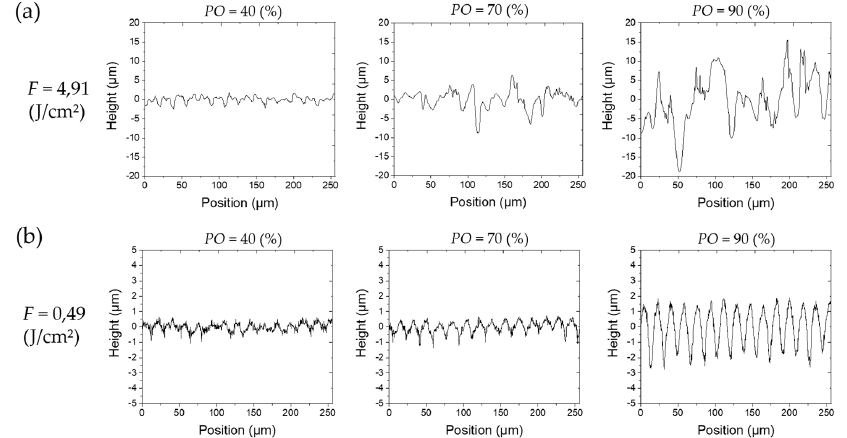
Figure 5. Exemplary height elevation profiles in x-direction for different PO (40%, 70%, and 90%) and different fluences ( F = 4.91 J/cm² and F = 0.49 J/cm²), respectively. ( a ) A clear formation of stochastic microstructures can be observed at a high level of PO at F = 4.91 J/cm². Width and height of the structures rise with increasing PO . ( b ) At F = 0.49 J/cm², the height of deterministic structures grows and periodicity remains constant with increasing PO . Structures are covered with nanoscale roughness.